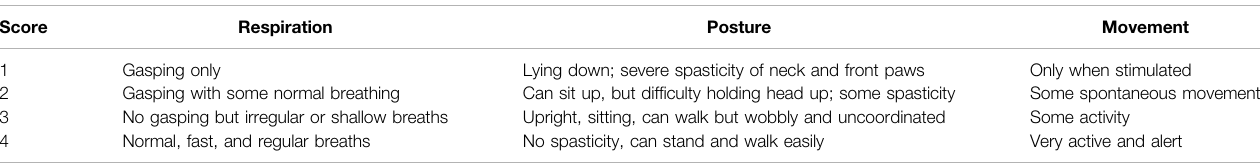
TABLE 1 | Wellbeing scoring.